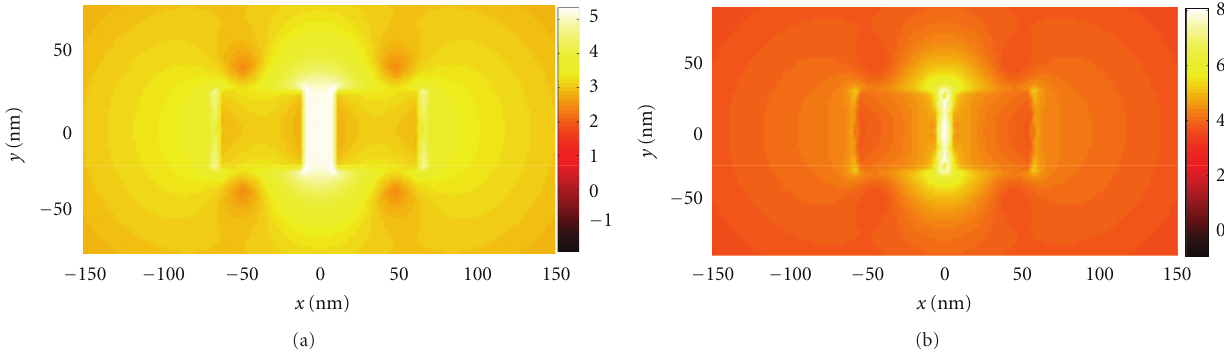
Figure 5: E field intensity ( | E | / | E 0 | ) 2 at the design wavelength of 840 nm for (a) gap size of 20nm and (b) gap size of 5nm (log scale).